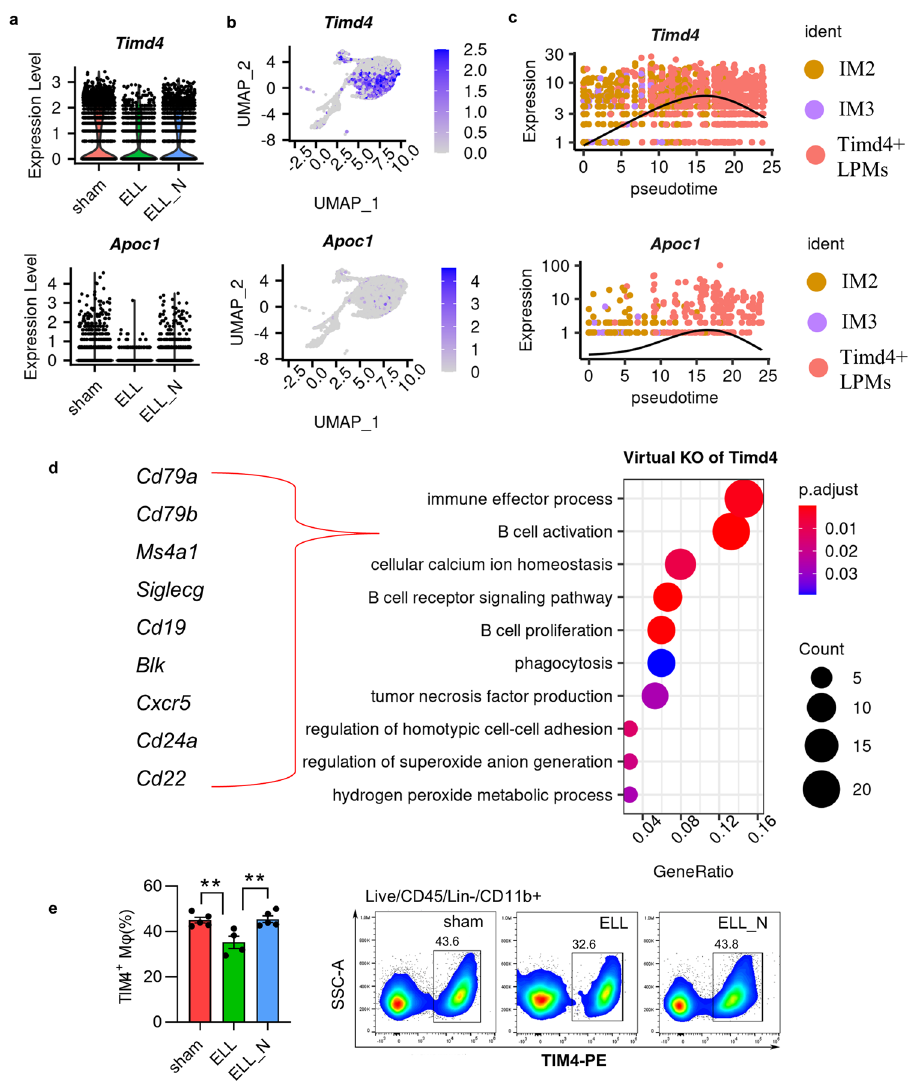
Fig. 7 Niclosamide preserves the population of embryo-derived resident “ large ” peritoneal macrophages. a Vlnplot shows gene expression of Timd4 and Apoc1 . All genes shown here were signi fi cantly ( p < 0.05) differentially expressed as determined by the “ wilcox ” test within the Seurat package. b The featured plot shows the distribution of Timd4 and Apoc1 . c Dynamic changes of genes along the trajectory path of maturation and replenishment. d GO terms of biological processes that were enriched by perturbed genes affected by virtual KO of Timd4 . e Flow cytometer isolation and quanti fi cation of TIM4 + resident macrophages. ** p < 0.01, mean ± SEM, n = 5 per